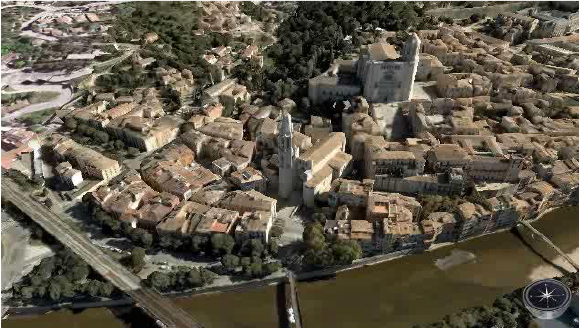
Figure 8: Photo-realistic 3D city model produced with oblique imagery with possible semantics and webGIS exploitations.